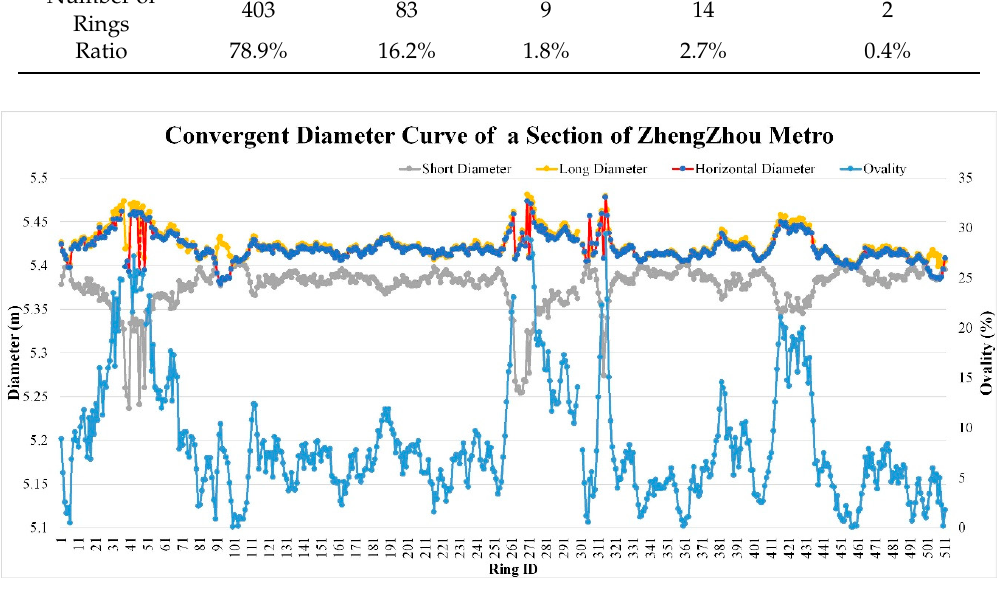
Figure 11. Diameter and ovality convergence curves.